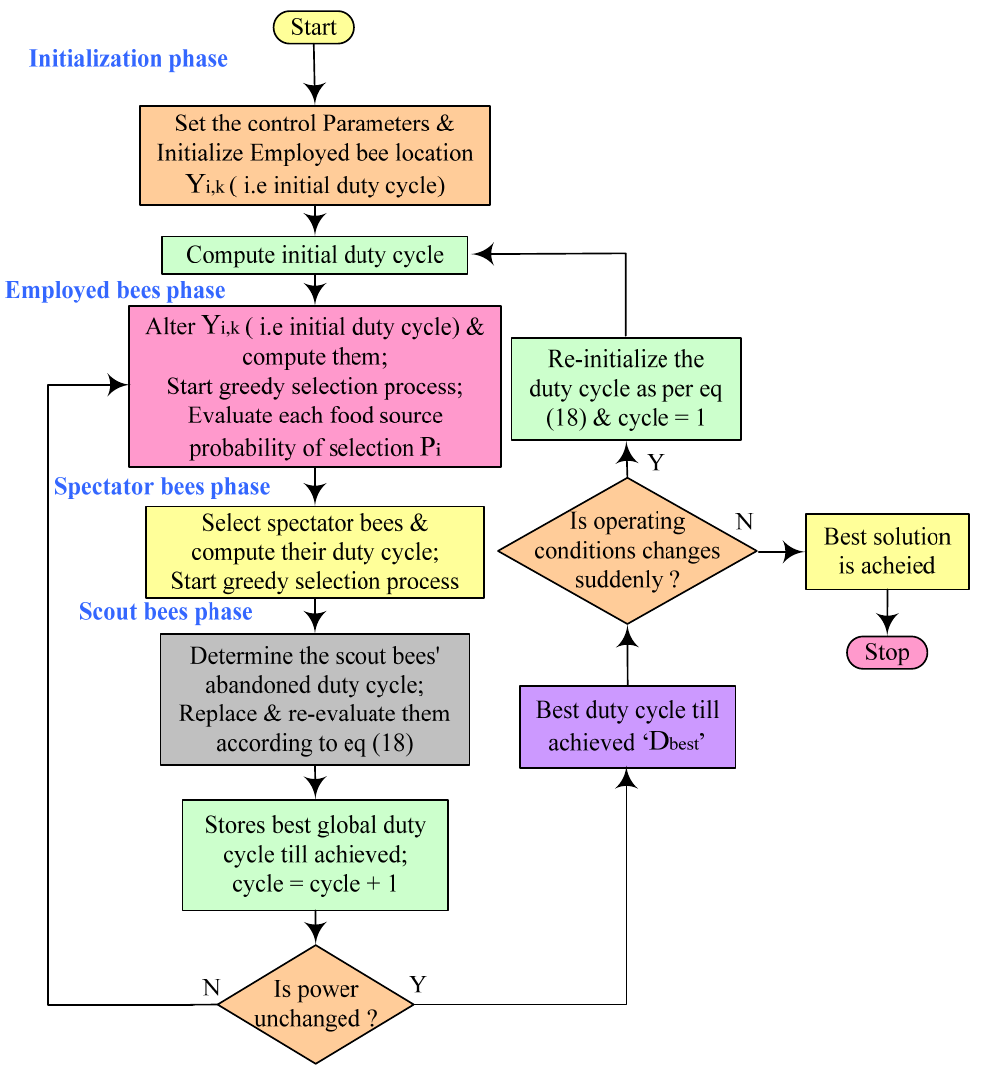
Figure 14. ABC-based MPPT technique [50].